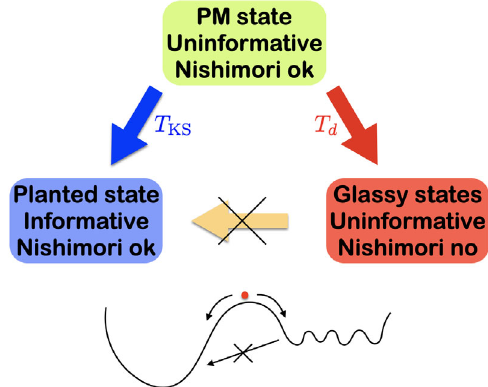
FIG. 8. A schematic picture of the general scenario faced by an annealing process looking for the planted signal. Decreasing the temperature, the fate of the annealing algorithm is determined by which critical temperature is met first between T explained in the text). The lower diagram should remind us that once the system gets trapped in glassy states it cannot reach the planted signal anymore due to the large